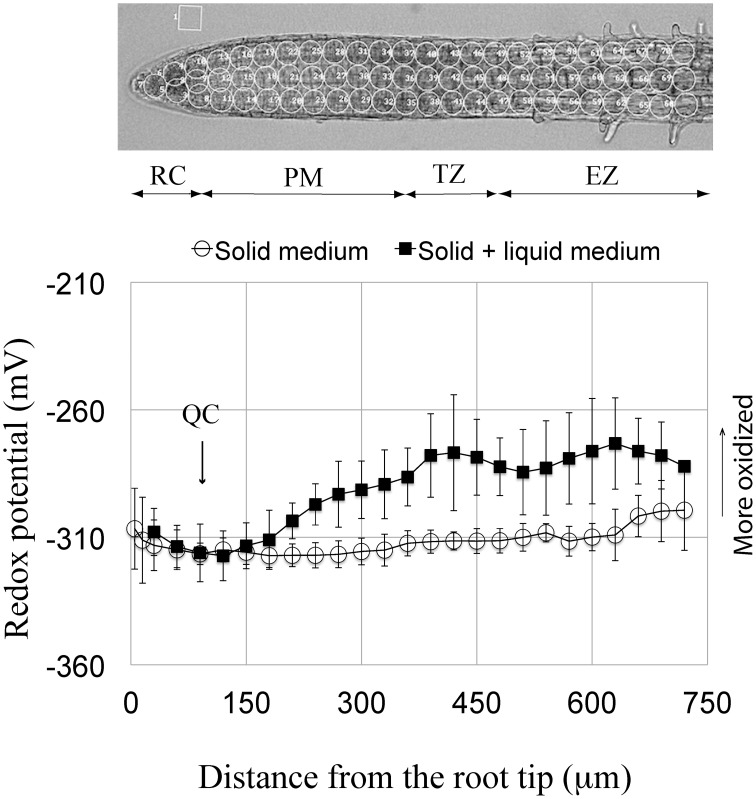
Redox potential profile of the primary root tip of Arabidopsis. Circled regions in the root above the profiles indicate areas of the redox measurements. Two profile curves are shown; one from roots grown continuously on solid 0.5x MS agar medium (open circles) and the other (solid squares) shows the redox profile from roots grown for 5 days on 0.5x MS agar and then immersed in 0.5x MS liquid medium for 3–24 h. Each curve is a summation obtained by averaging the measurements from the individual, corresponding curves shown in Supplementary Figure 1 (i.e., for immersion, averaging control curves from 3, 6, 12, and 24 h, and for growth on solid medium only, averaging the control curves from 3, 6, and 9 days). Standard deviations are shown for the 48 roots used to obtain the redox profile for roots grown continuously on agar, and for the eight roots used to obtain the redox profile for roots grown on agar with subsequent immersion. The more negative the potential, the more reduced is the redox status. Note that the two curves overlap in the distal-most 180 μm of the root. RC, root cap; QC, quiescent center; PM, proximal meristem; TZ, transition zone; EZ, elongation zone.